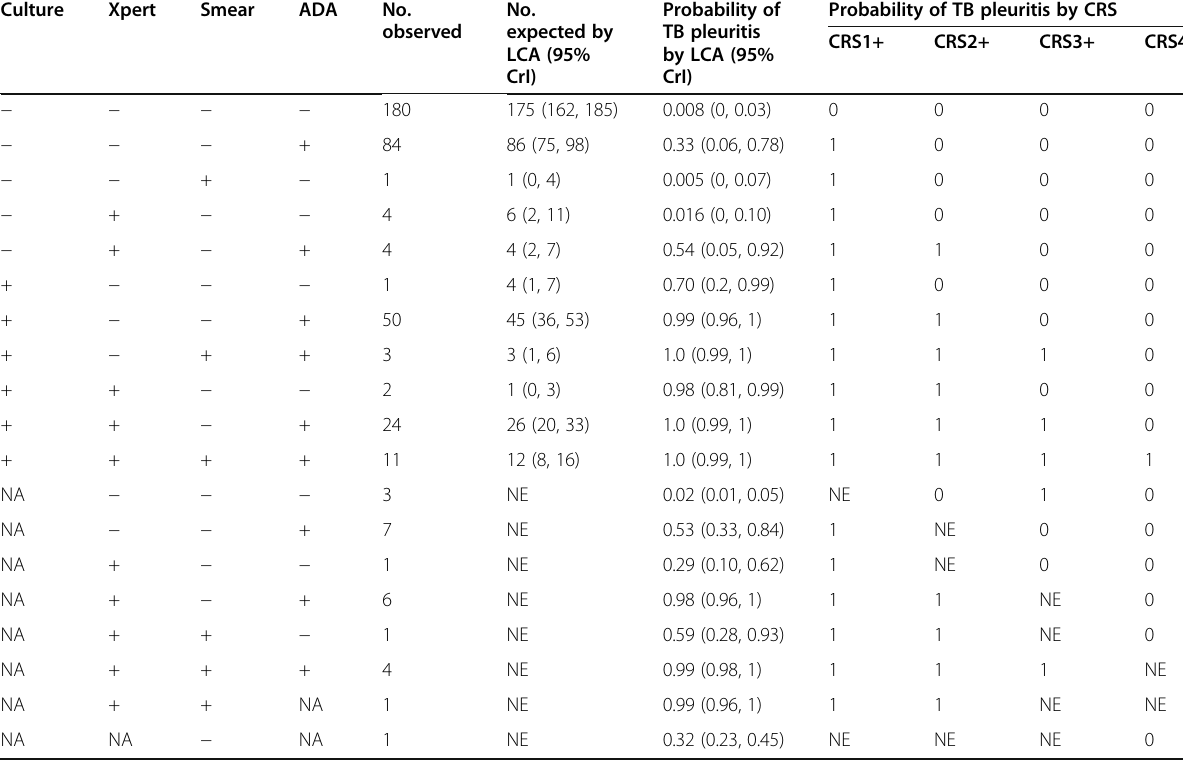
Table 6 Observed counts, expected counts, and TB pleuritis probability by test result pattern